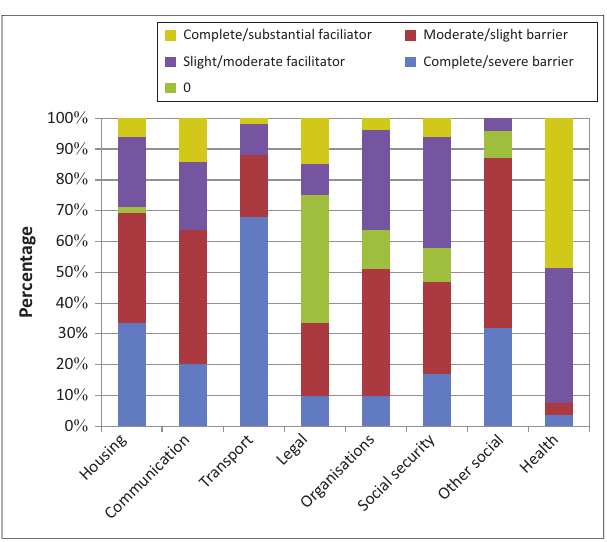
FIGURE 5: Services, systems and policies experienced as barriers and facilitators ( n =